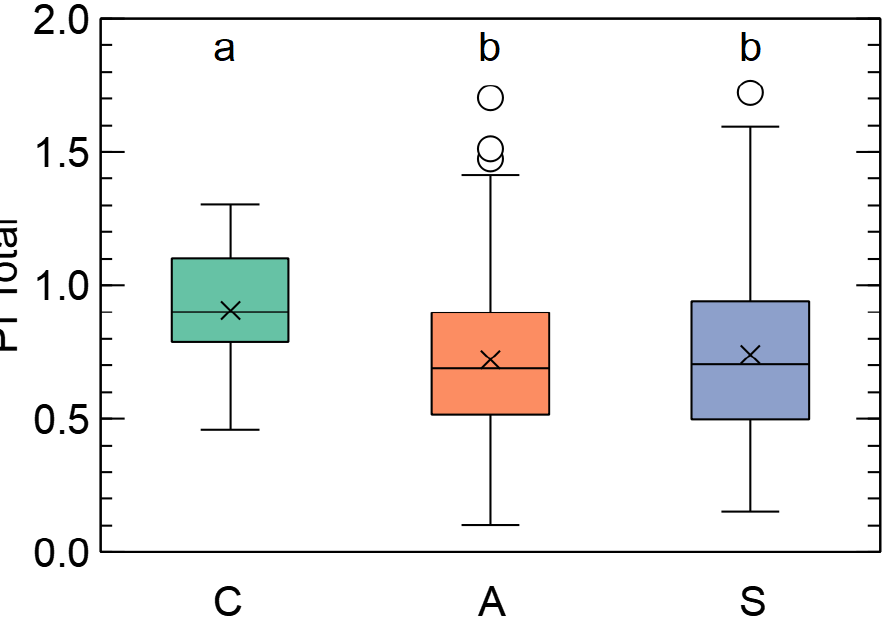
Figure 1. Photosynthetic activity (overall performance index PI total) compared to soil amendments with phosphogypsum mixed with organic ash—A, sewage sludge—S and control—C. The lowercase Latin characters above box plots, if the same, indicate that there is no statistically significant difference between the groups at p < 0.05. In the plot, boxes span from 1st to 3rd quantile, with the median indicated by a line, whiskers indicating 1.5 inter-quantile range, the × symbol mean value, and circles outlier